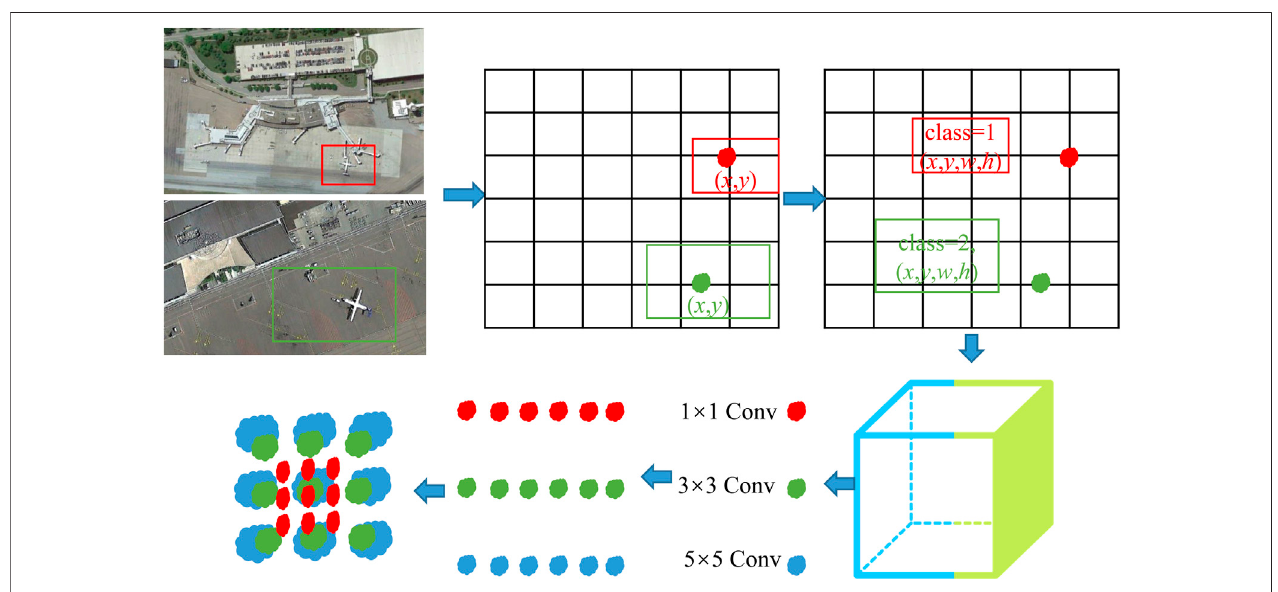
FIGURE 4 | Detection principle of the YOLO